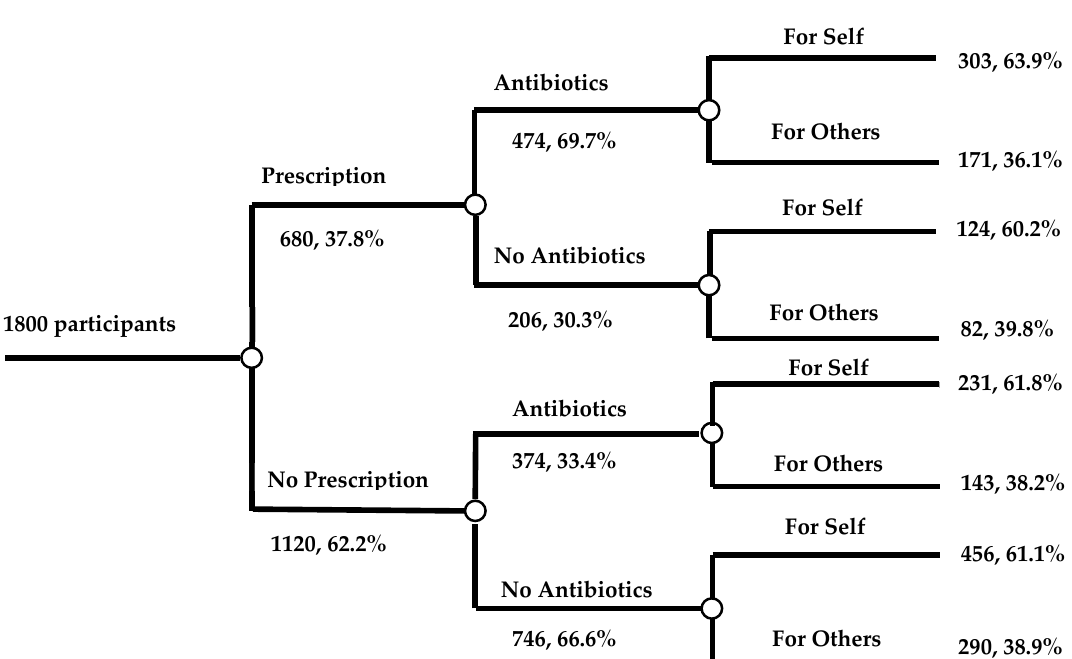
Figure 1. Purpose of customers visiting the community pharmacies. Table 1. Demographic information of customers ( n = 1800).